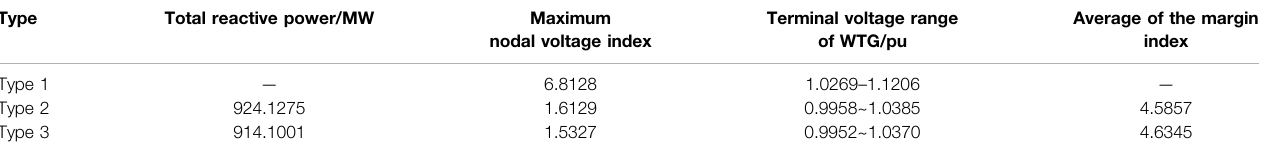
TABLE 1 | Comparison of optimized results by different control